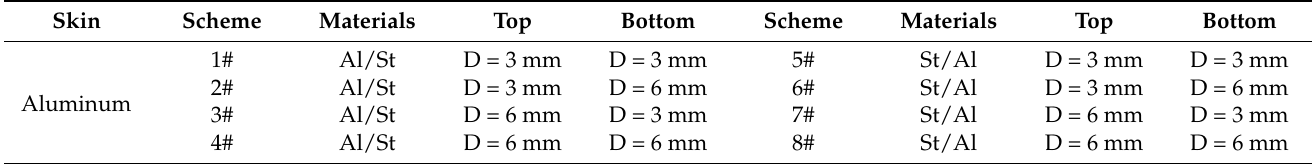
Table 2. Honeycomb material structure dimension